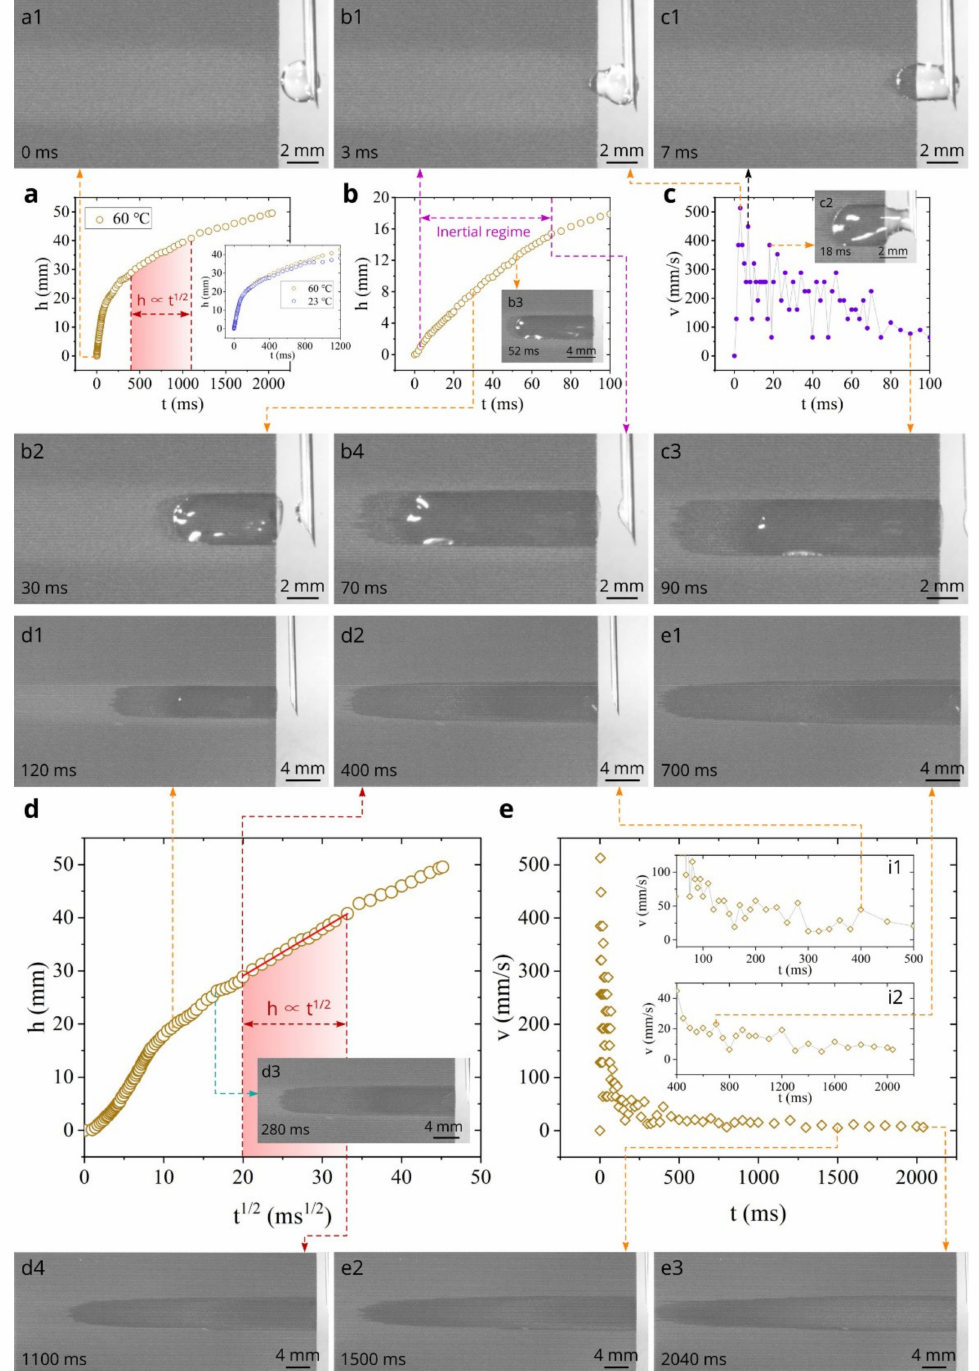
Figure 5. Obtained h ( t ) and v ( t ) plots along with snapshots of water spreading at 60 ◦ C for sample #1. ( a ) Overall plot of the spreading distance as a function of time between 0 and 2040 ms (a1 is a snapshot of the sample surface and water drop at t = 0). ( b ) Detailed plot of the spreading distance as a function of time between 0 and 100 ms (b1–b4 are snapshots of water spreading associated with h ( t ) dependence). ( c ) Plot of the velocity as a function of time between 0 and 100 ms (c1–c3 are snapshots of water spreading associated with v ( t ) dependence). ( d ) Plot of the spreading distance as a function of t 1/2 (d1, d3 are snapshots of water spreading related to visco-inertial regime; d2, d4 are snapshots of water spreading related to Washburn’s regime). ( e ) Overall plot of the velocity as a function of time between 0 and 2040 ms (e1–e3 are snapshots of water spreading associated with v ( t ) dependence. The insets i1 and i2 show detailed v ( t ) dependencies in the time domains of 100–500 and 400–2040 ms,